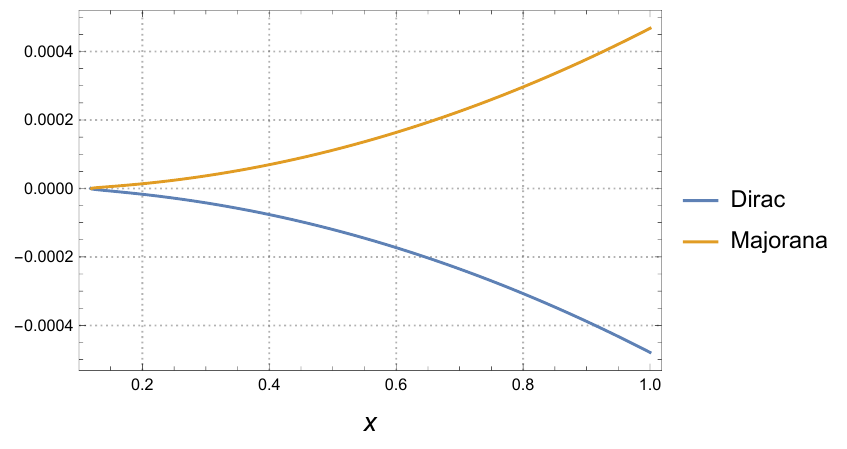
Figure 6. Neutrino mass contribution to Dirac and Majorana